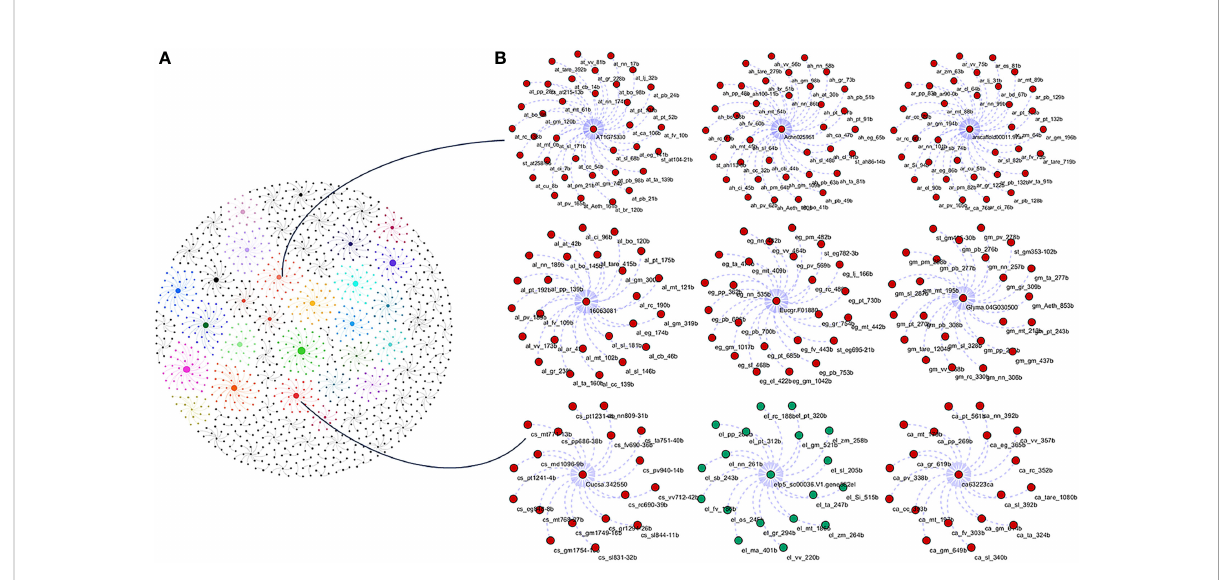
FIGURE 1 Kingdom-wide microsyntenic network of carbamoyltransferase genes, showing the major syntenic hubs in plant groups for aspartic and ornithine carbamoyltransferase genes. (A) The kingdom-wide microsyntenic network in globe net layout, where different colors represent different lineage-speci fi c groups and node size represents connected syntenic genes. (B) The zoomed representation of lineage-speci fi c groups showing major hubs, where the red color is for dicots and the green color is for monocot